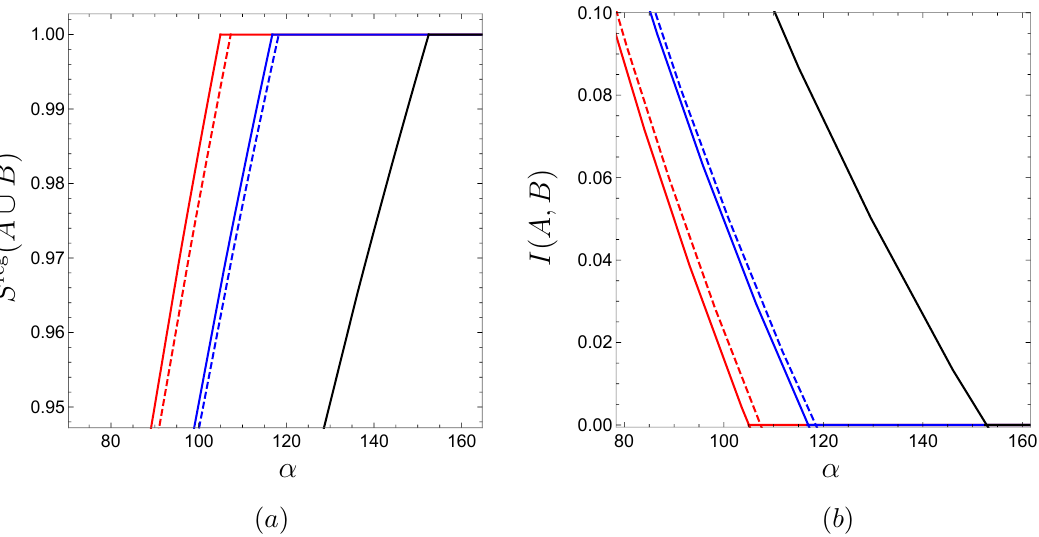
Figure 7 . (a) S reg ( A [ B ) as a function of (cid:11) . (b) Mutual information I ( A; B ) (in units of V 2 =G as a function of (cid:11) . All the curves have the same mutual information I ( ‘ ) = 1 at (cid:11) = 0. Both in (a) and (b) the curves correspond to a=T = 0 (black curve), a=T = 8 : 56 (blue curves) and a=T = 21 : 57 (red curves). The continuous/dashed curves represent the result for a strip orthogonal/parallel to the anisotropic direction. Here we have (cid:12)xed T = 1 =(cid:25) .